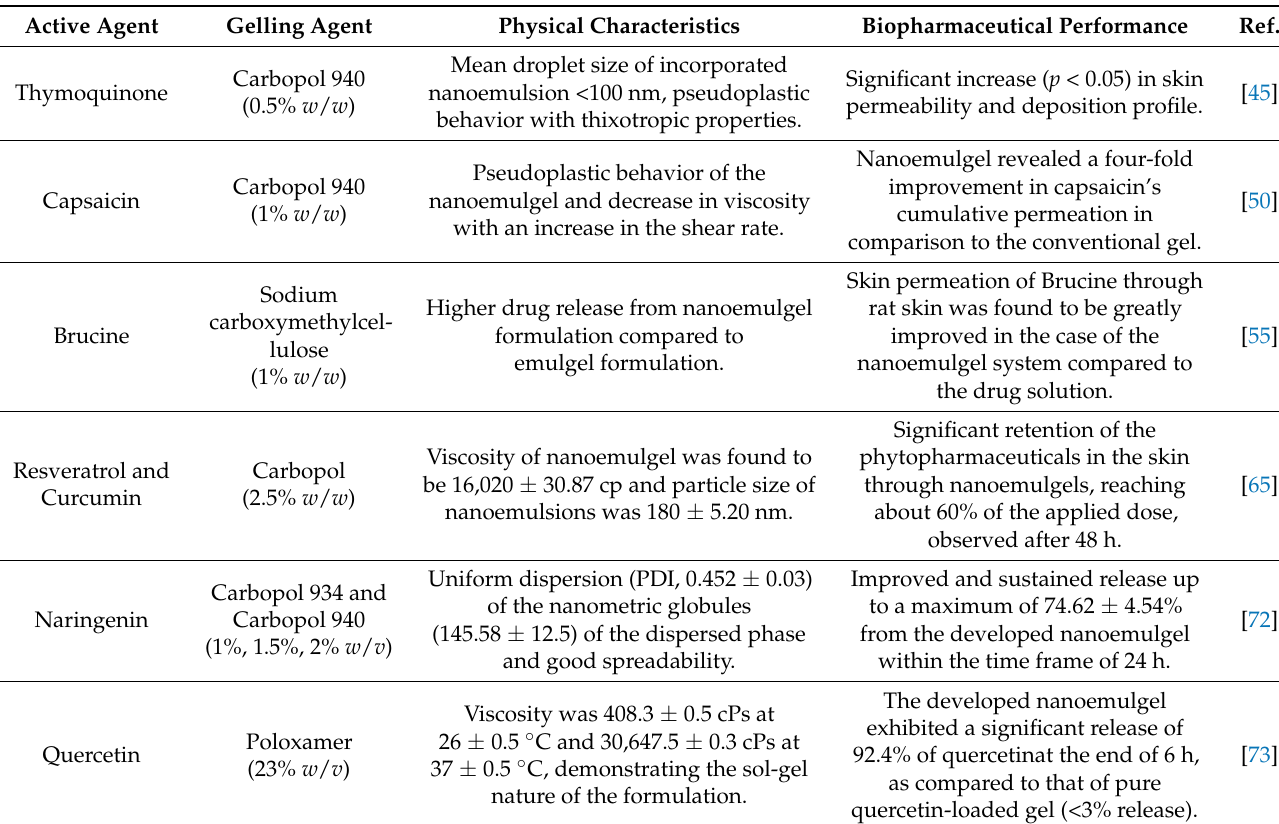
Table 1. Physicochemical characteristics and biopharmaceutical performance of phytopharmaceutical- containing nanoemulgel